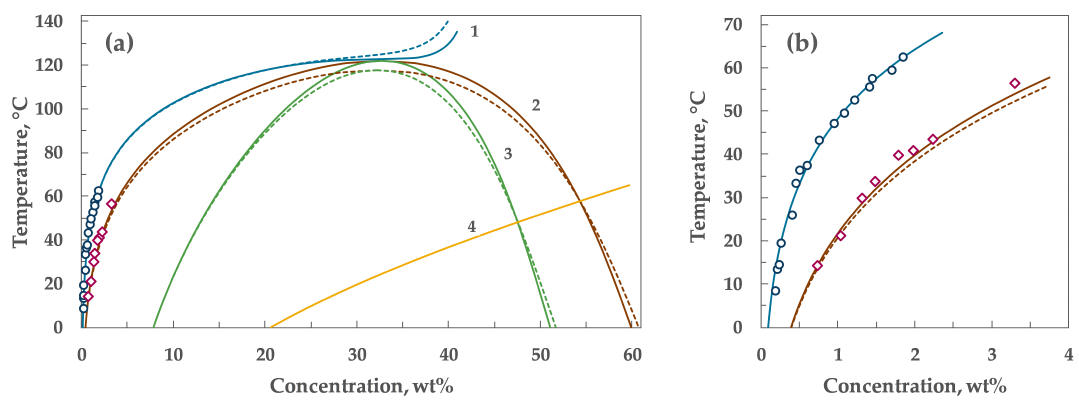
Figure 2. Experimental data and model predictions for the compound Z – methanol / water system showing ( a ) the complete phase diagram, and ( b ) magnified view of the experimental data region. The open circles and diamonds indicate the experimental data points for solubility and oiling out (binodal), respectively, adapted from [11]. Curve 1 represents the model ( µ l = µ s ) fit to solubility data using Equations (16) and (17). The square-well interaction parameters (listed in Table 2) obtained from this fit were used to further calculate the binodal (curve 2), spinodal (curve 3), and the gelation (curve 4) boundaries. The dotted lines are the curves obtained using Equation (11) and the solid lines are those obtained with Equation (12), respectively, for calculating η e ff . The dotted and solid lines for curve 4 are almost identical.